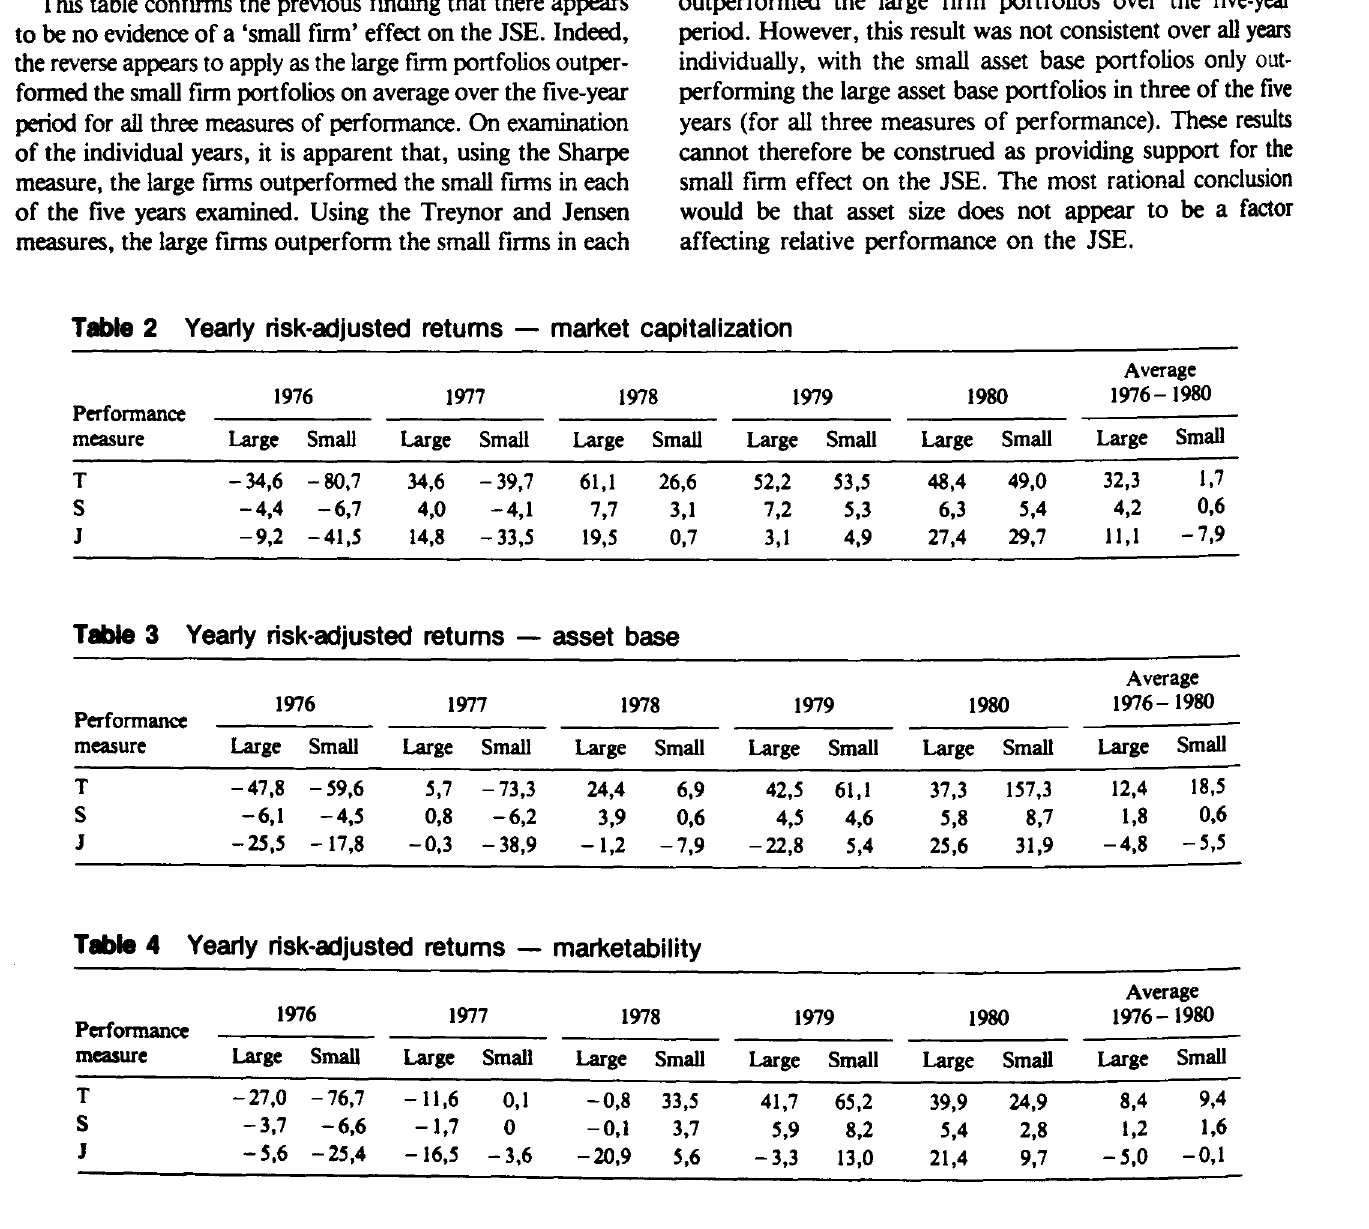
Yearly risk-adjusted returns - market capitalization